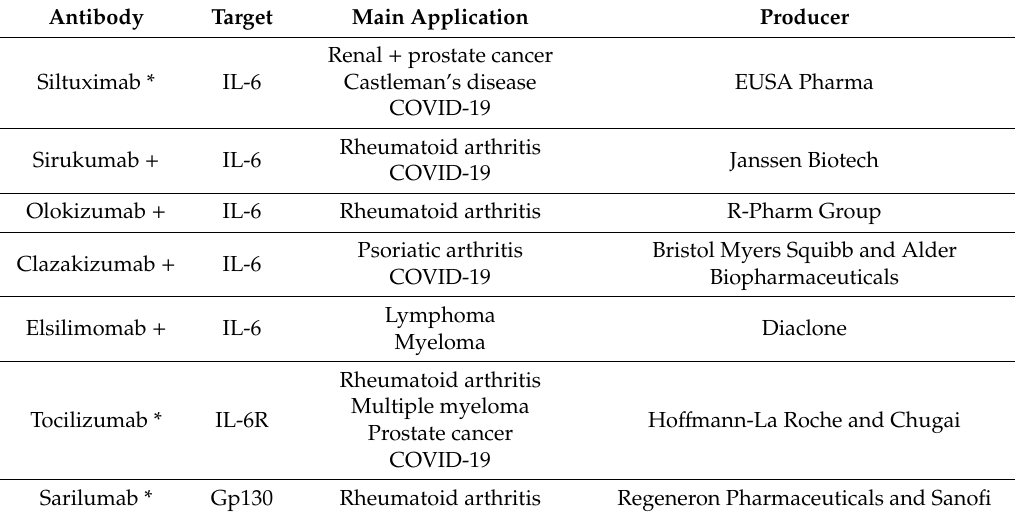
Table 4. Examples of antibodies designed to target IL-6, IL-6R and gp130.